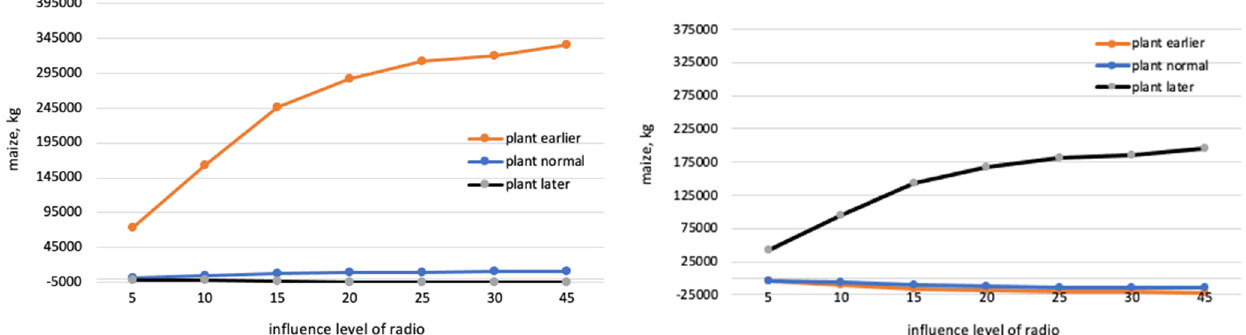
Figure 9. Influence of radio in the Kebele.